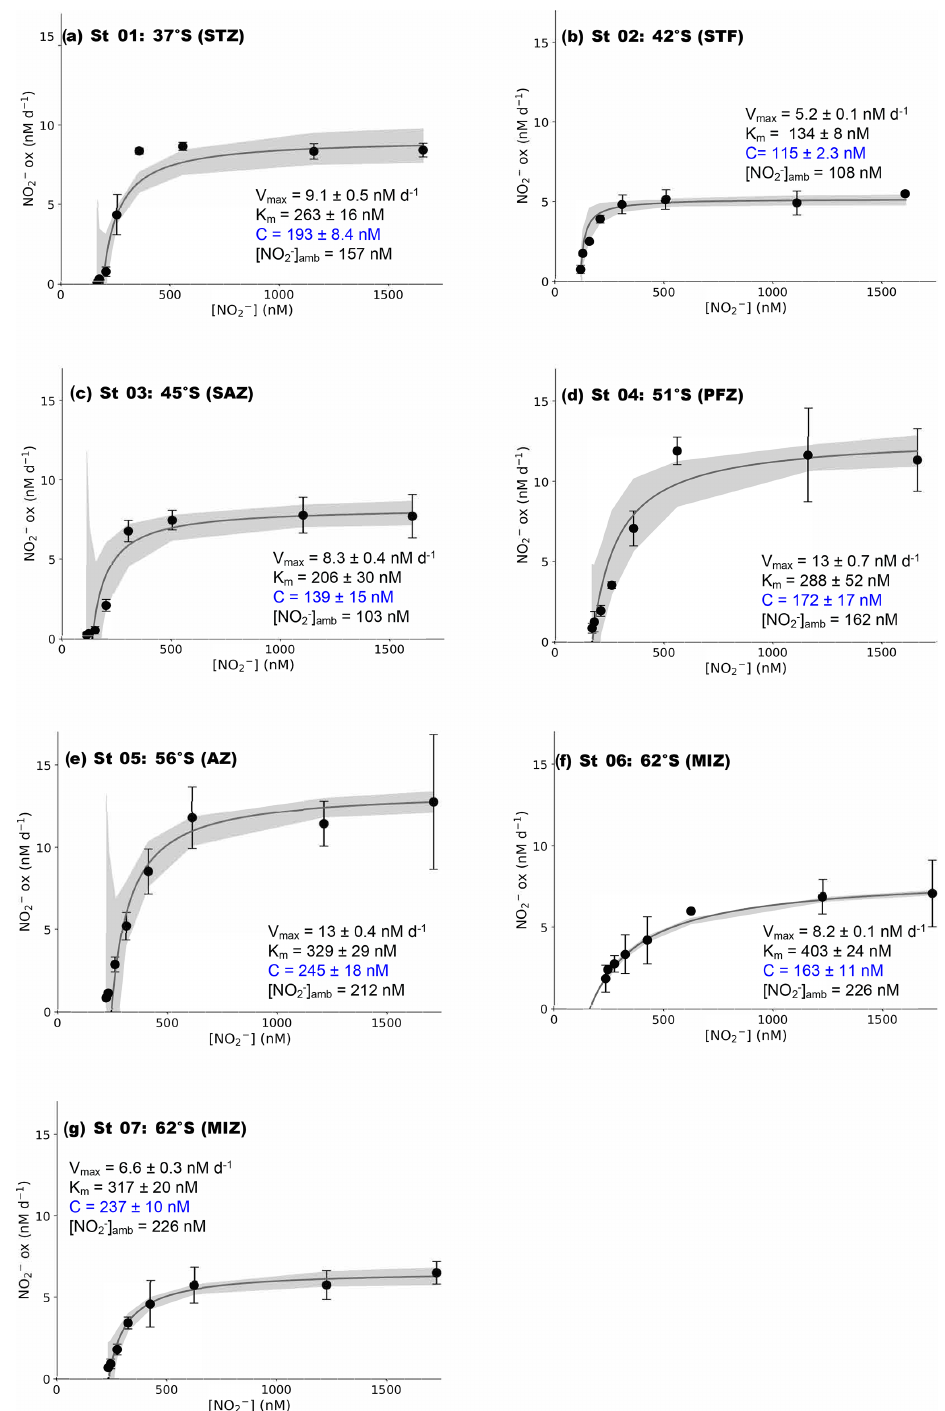
Figure 2. Kinetics experiments: the dependence of the NO − at (a) St 01, 37 ◦ S (STZ), (b) St 02, 42 ◦ S (STF), (c) St 03, 45 ◦ S (SAZ), (d) St 04, 51 ◦ S (PFZ), (e) St 05, 55 ◦ S (OAZ), (f) St 06, 62 ◦ S (MIZ), and (g) St 07, 62 ◦ S (MIZ). The solid lines show the Michaelis–Menten best fit, with the derived values of V max , K m , and C , as well as the ambient concentration of nitrite ([NO − bars are not visible, they are smaller than the data markers. The grey shaded area shows the 95% confidence interval associated with the model fit. Note that the x axis represents total [NO −